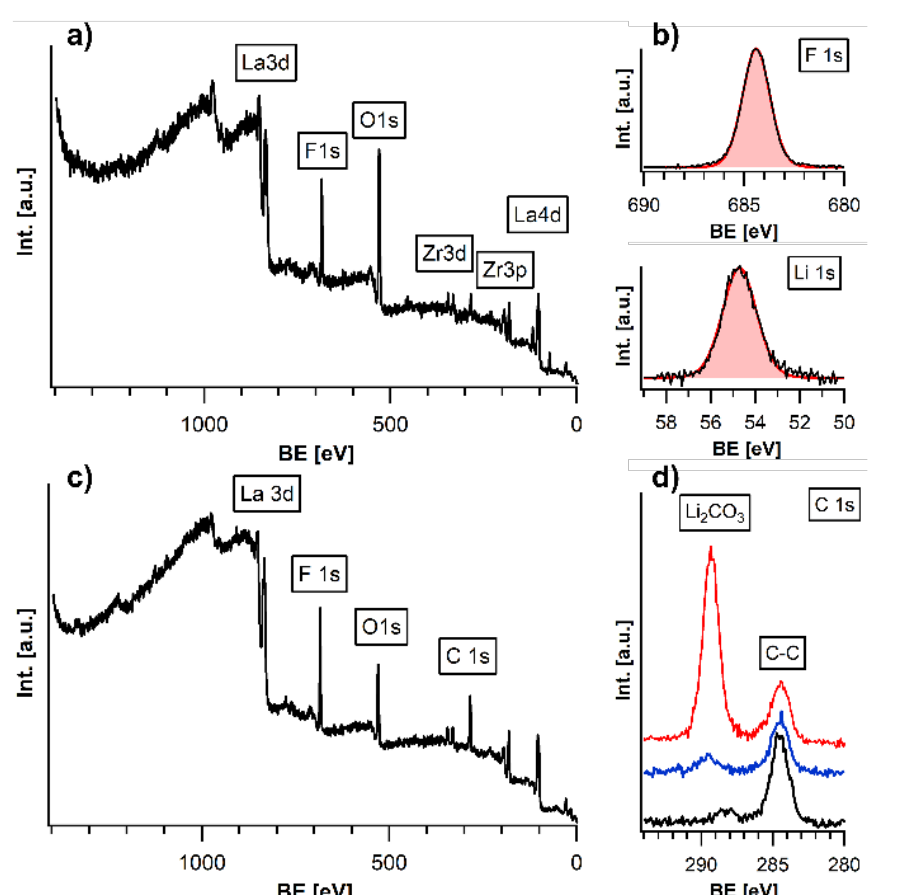
Figure 2. ( a ) XPS survey spectrum of gas-phase fluorination LiF coated LLZTO. ( b ) Detailed Li1s and F1s spectra of gas-phase fluorination LiF coated LLZTO. ( c ) XPS survey spectrum of gas-phase fluorination LiF coated LLZTO after 24 h in ambient air. ( d ) Comparison of the detailed XPS C1s emission lines of an uncoated LLZTO (red), sputter-coated LLZTO (blue), and gas-phase fluorinated LLZTO (black) after air